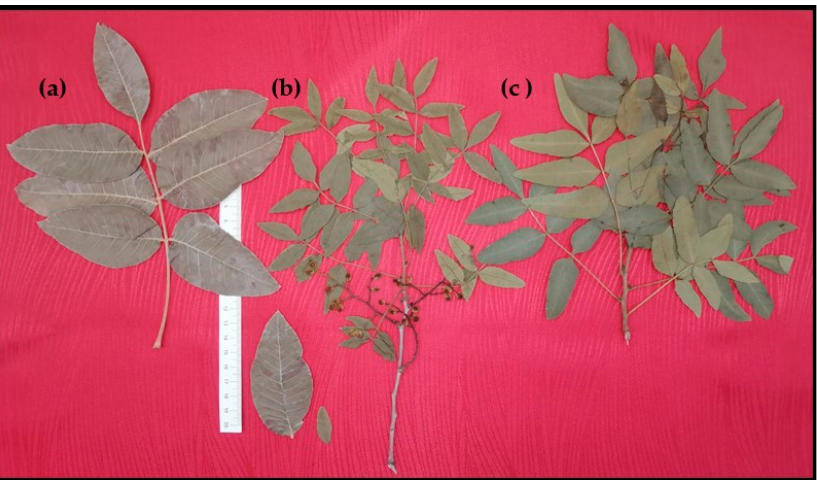
Figure 3. Pistacia atlantica leaves from different countries: ( a ) one of the largest Pistacia atlantica subsp. atlantica leaf, from Northwest Algeria, September 2014; ( b ) Pistacia atlantica subsp. atlantica branch with leaves and unripe fruits, from Marrakech, Morocco, March 2018; ( c ) branch with Pistacia atlantica leaves, in the town centre of Famagusta (Northern Cyprus), October 2017. Personal photo taken by the first author.